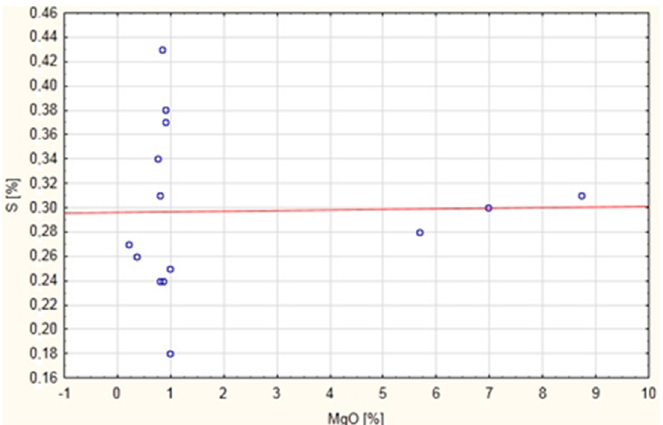
Figure 18. The amount of absorbed sulfur S (%) of the post-reaction product by carbonate sorbent samples with varied content of MgO (%) [21]. Red line- the trend line of the probable increase.